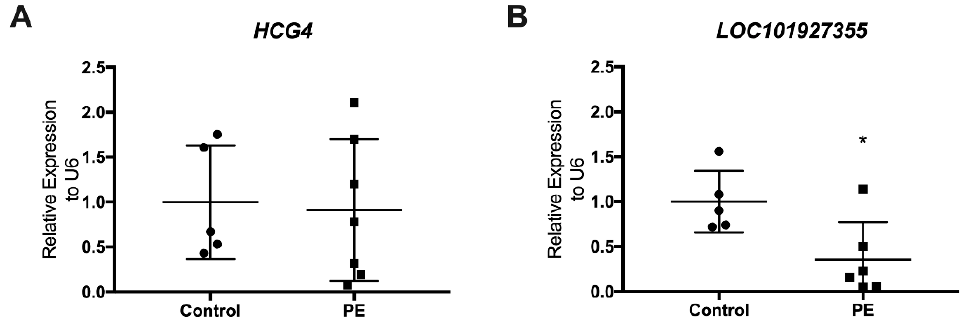
Figure 4. LncRNAs’ expression in maternal plasma. Two lncRNA were detected in maternal plasma at delivery in seven PE (squares) and five control (circles) plasma ( A ) HCG4 and ( B ) LOC101927355 ; * p < 0.05, Mann–Whitney test. The bars indicate the standard deviation.